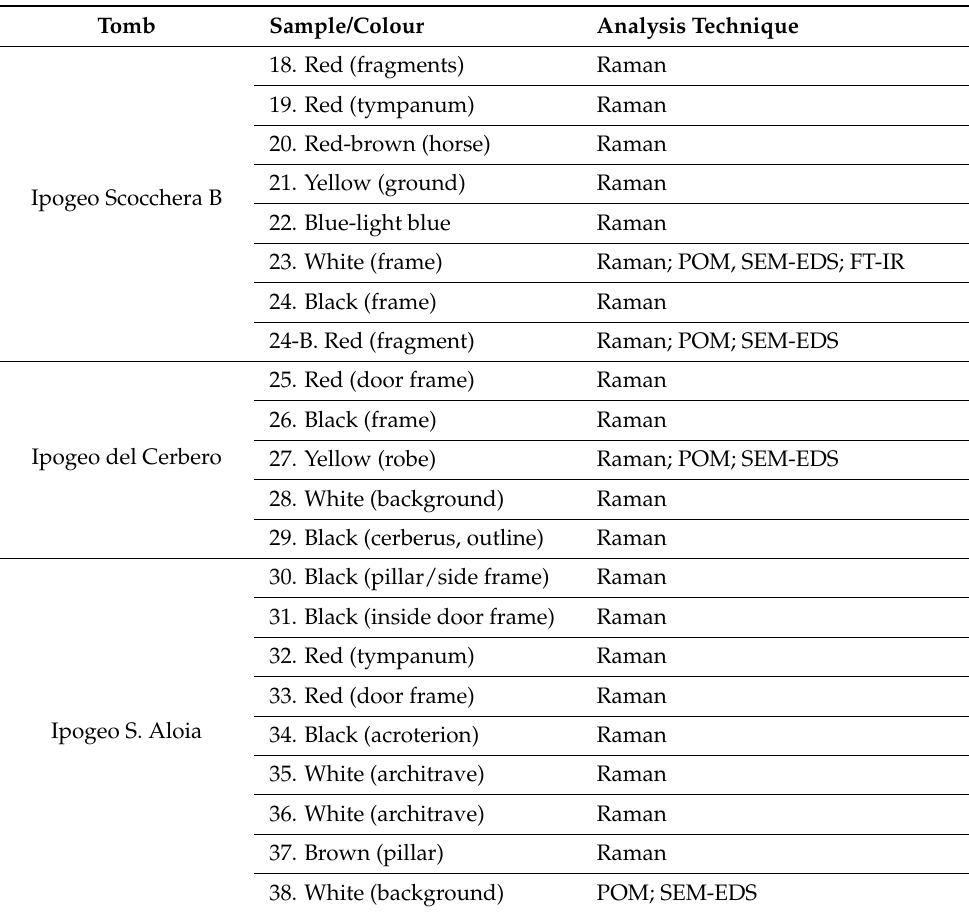
Table 6. Cont. Tomb Sample/Colour Analysis Technique